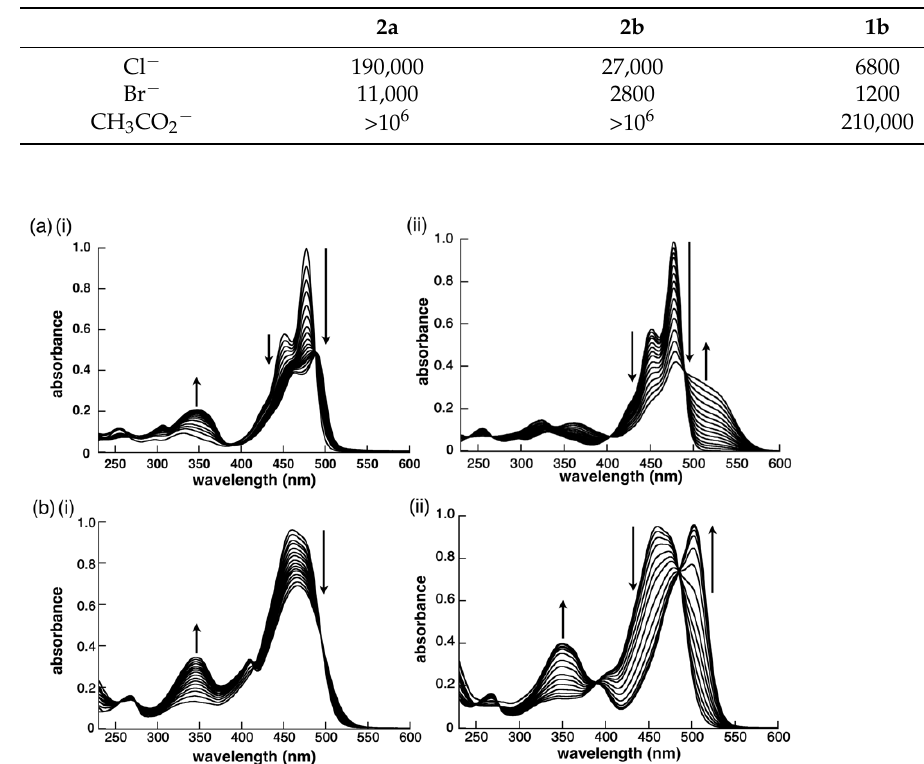
Figure 4. UV/vis absorption spectral changes of ( a ) 2a (0.01 mM) and ( b ) 2b (0.02 mM) upon the addition of ( i ) Cl − and ( ii ) CH 3 CO 2− as TBA salts in CH 2 Cl 2 . addition of ( i ) Cl − and ( ii ) CH 3 CO 2 − as TBA salts in CH 2 Cl 2 Table 1. Binding constants (K a , M −1 ) of 2a , b and 1b [17] as a reference for various anions in CH 2 Cl 2 .